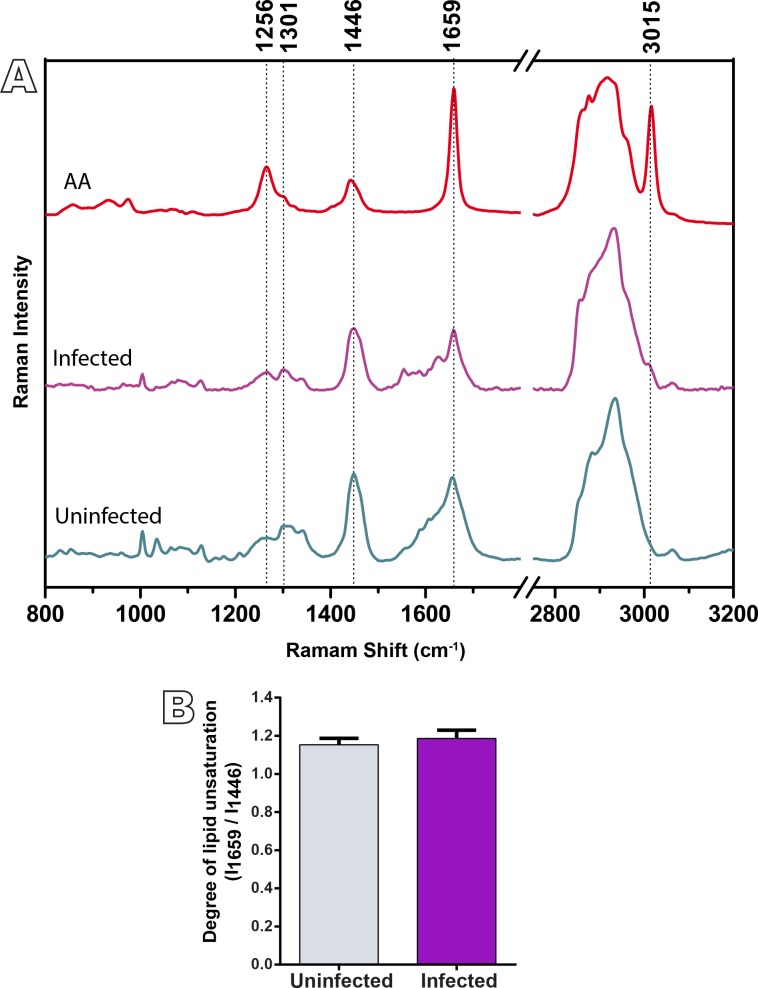
Raman spectra reveal high content of polyunsaturated fatty acids (PUFAs) in both uninfected and infected liver of N. squamipes.(A) The band at 3015 cm-1 is characteristic of PUFAs and is more prominent in arachidonic acid (AA) when compared to other PUFAs. The degree of unsaturation is shown in (B). Liver fragments of N. squamipes naturally infected and uninfected were fixed and analyzed by Raman spectroscopy without labeling. AA spectrum was obtained from pure AA (catalog number A3555, Sigma-Aldrich) diluted in ethanol. Data are representative of 3 independent experiments.